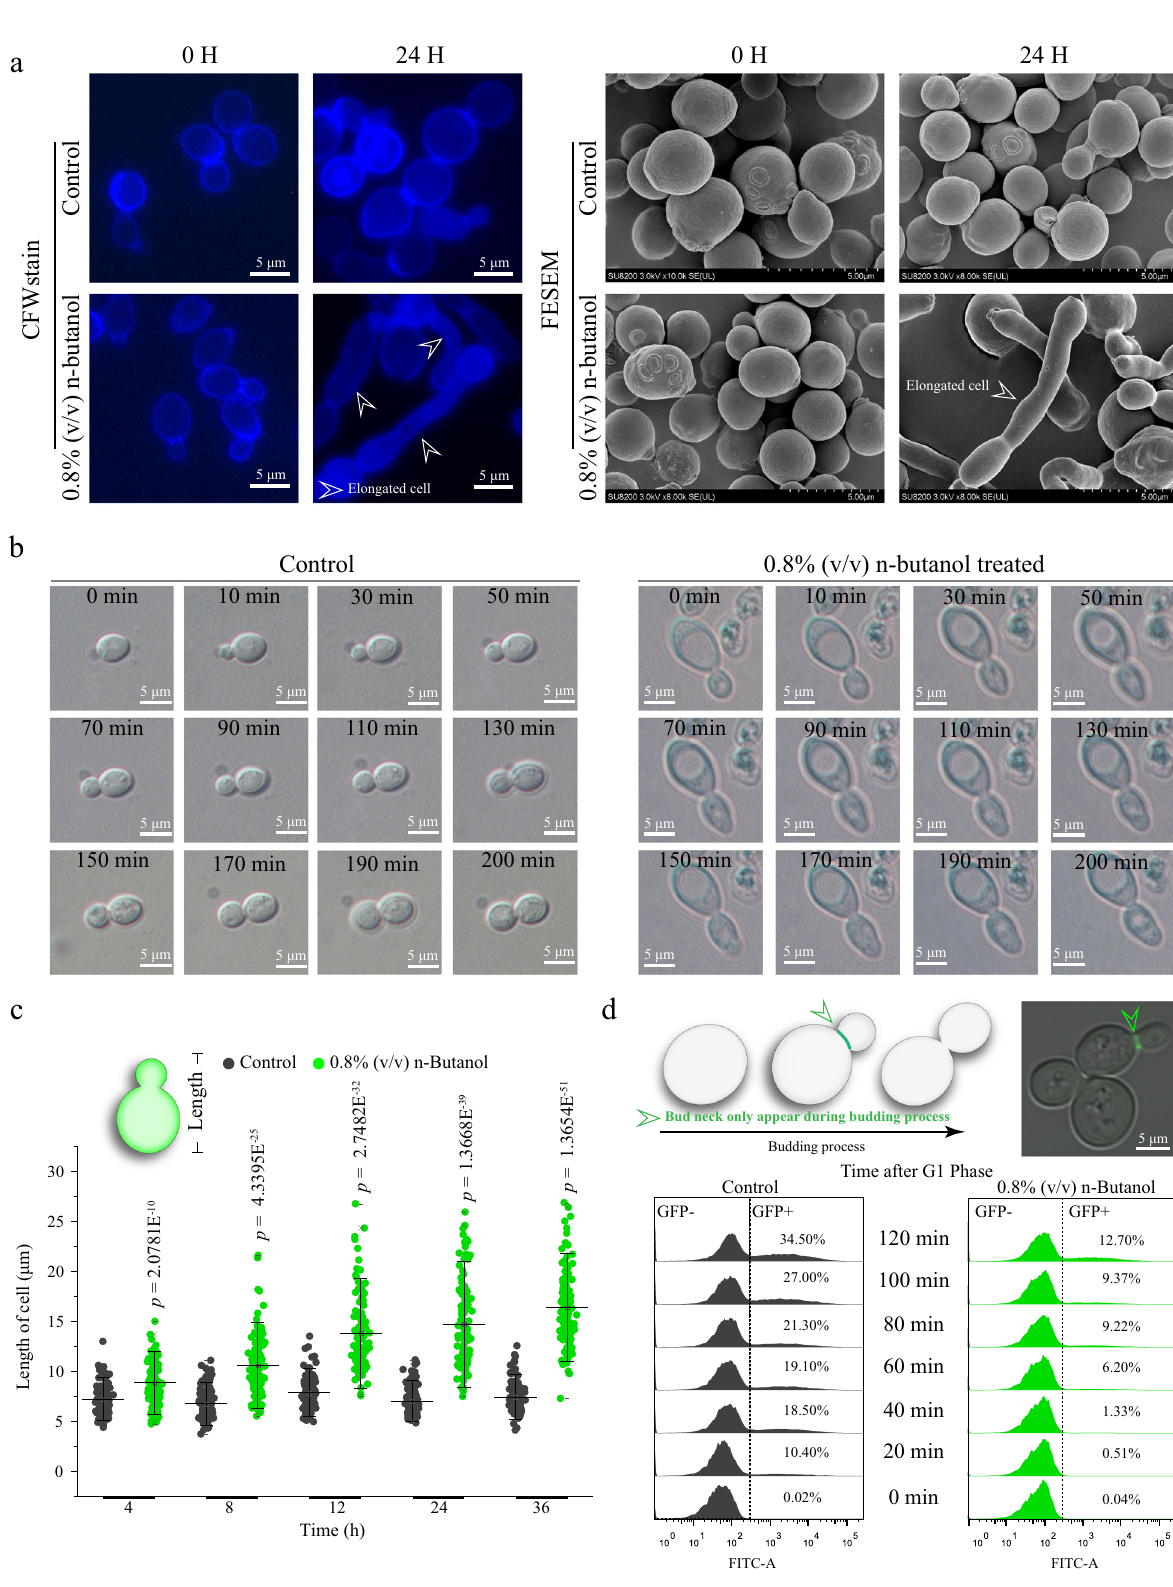
phase arrest, and the cells were then plated on yeast nitrogen base (YNB) medium containing 0.8% (v/v) n-butanol. The number of colony-forming units (CFUs) was used to indicate the relative budding index. Compared with the control strain, the spa2 deletion strain, cdc42 overexpression strain, and bud6 over- expression strain exhibited an increase in CFUs by 18.4%, 15.4%,